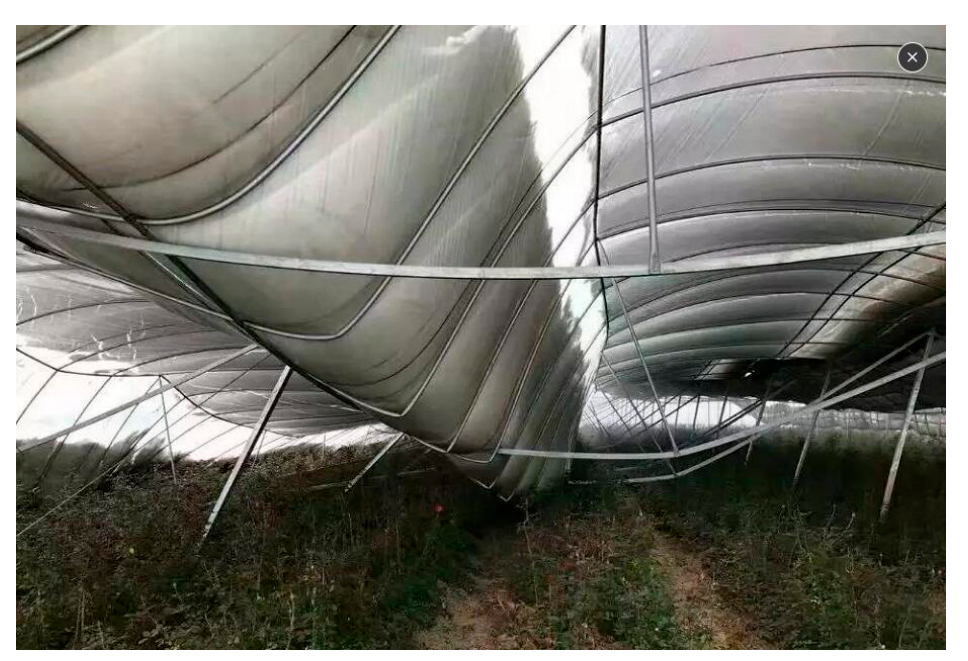
Figure 1. Collapse of greenhouse under snow load [9].